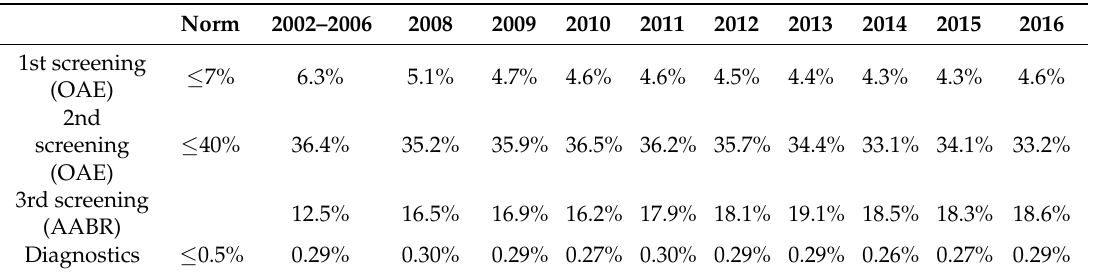
Table 2. Referrals per screening and for diagnostics